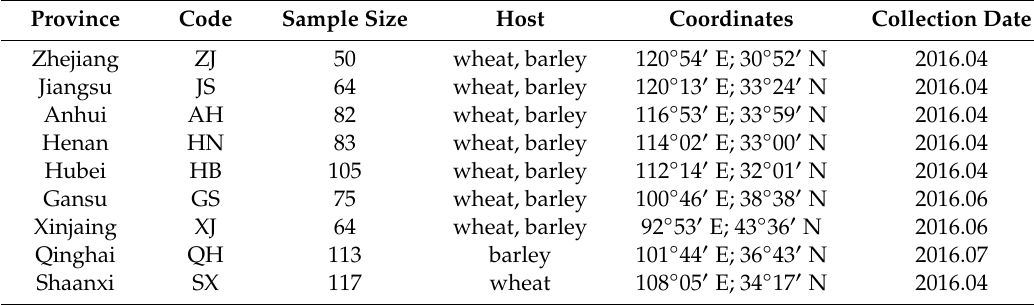
Table 1. Collection information for Sitobion avenae